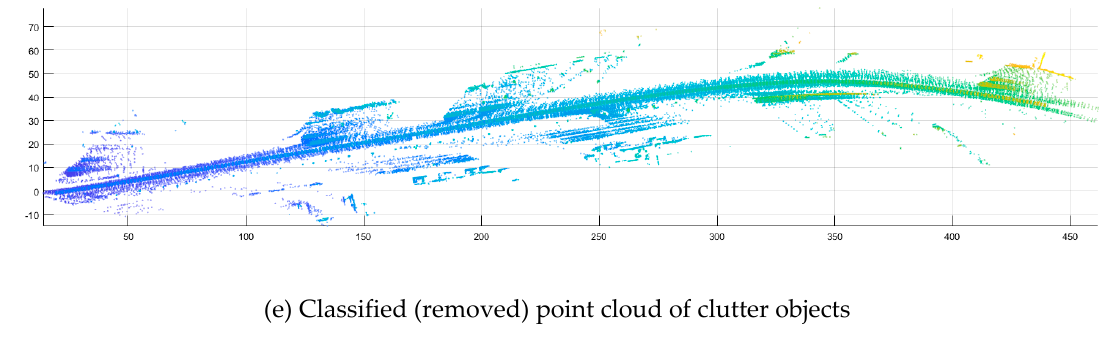
Figure 8. Results of clutter object removal.